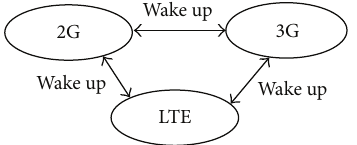
Figure 5: The 2G, the 3G, and the LTE wake up relationship.